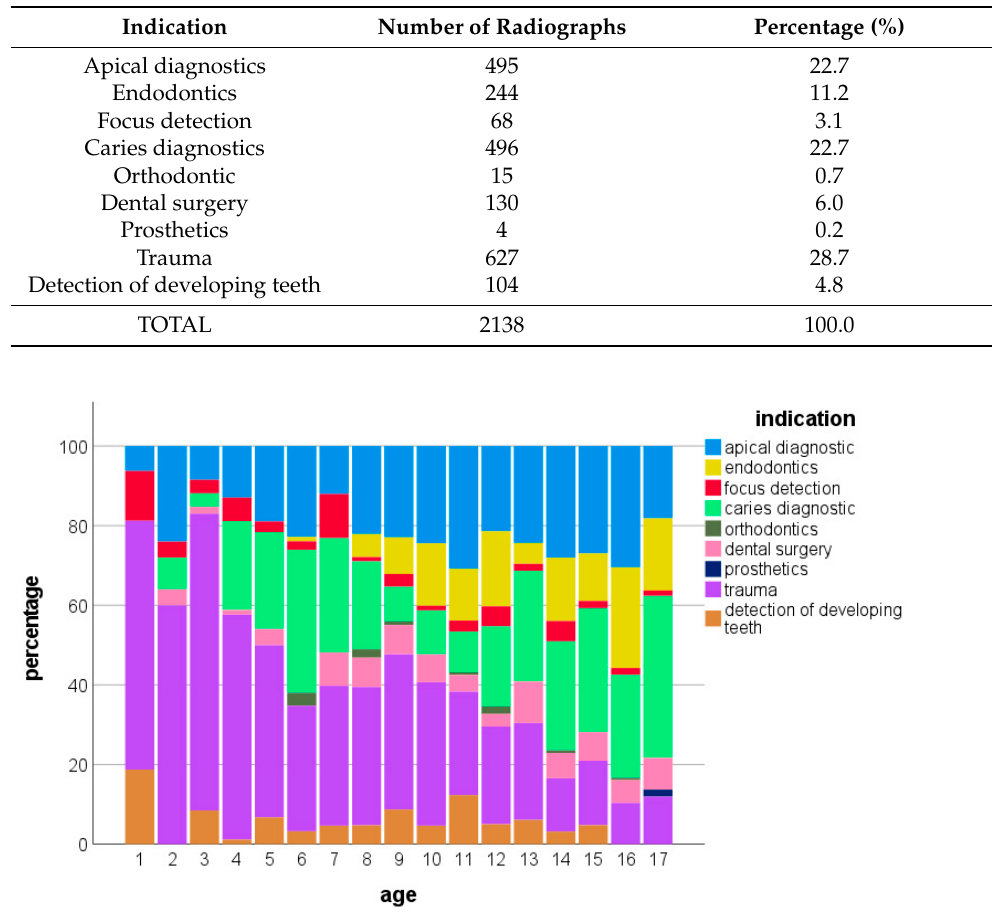
Figure 3. Age-related distribution of indications for intraoral radiographs. Table 2. Frequency of indications for intraoral radiographs.